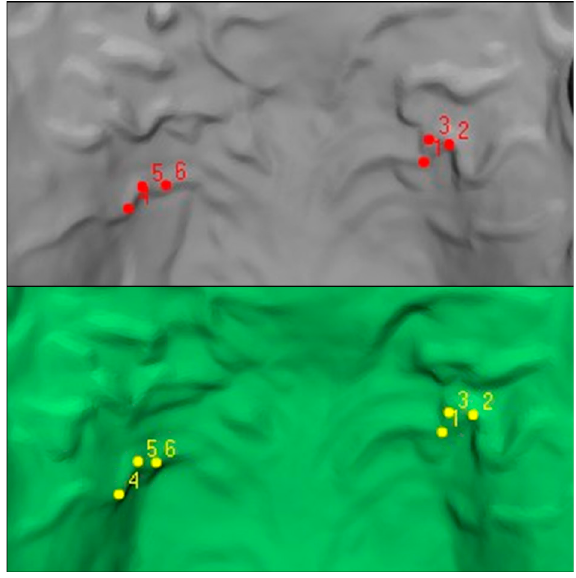
Figure 2. Point registration-based software. Identification of 6 landmarks on the medial two-third of the third palatal rugae of both pre-treatment (top) and post-treatment cast